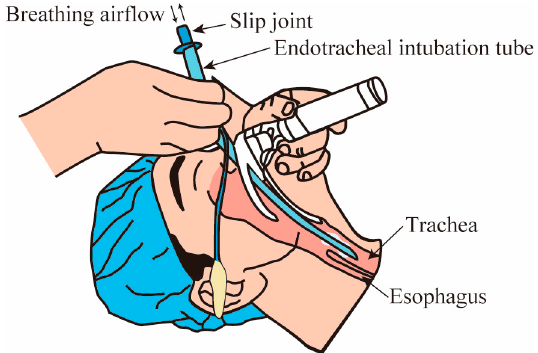
Figure 1. Endotracheal intubation tube inserted in airway [1].